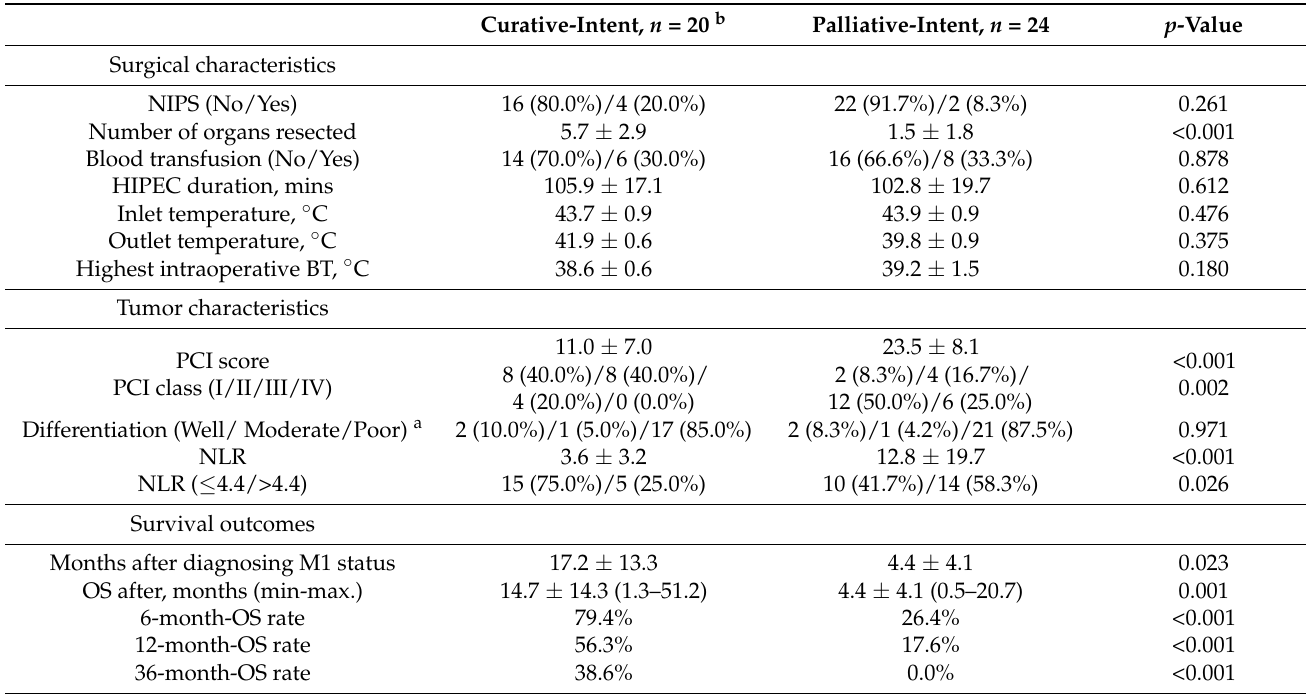
Table 2. Surgical procedures, pathologic data, and outcomes of metastatic gastric cancer patients who underwent CRS/HIPEC.